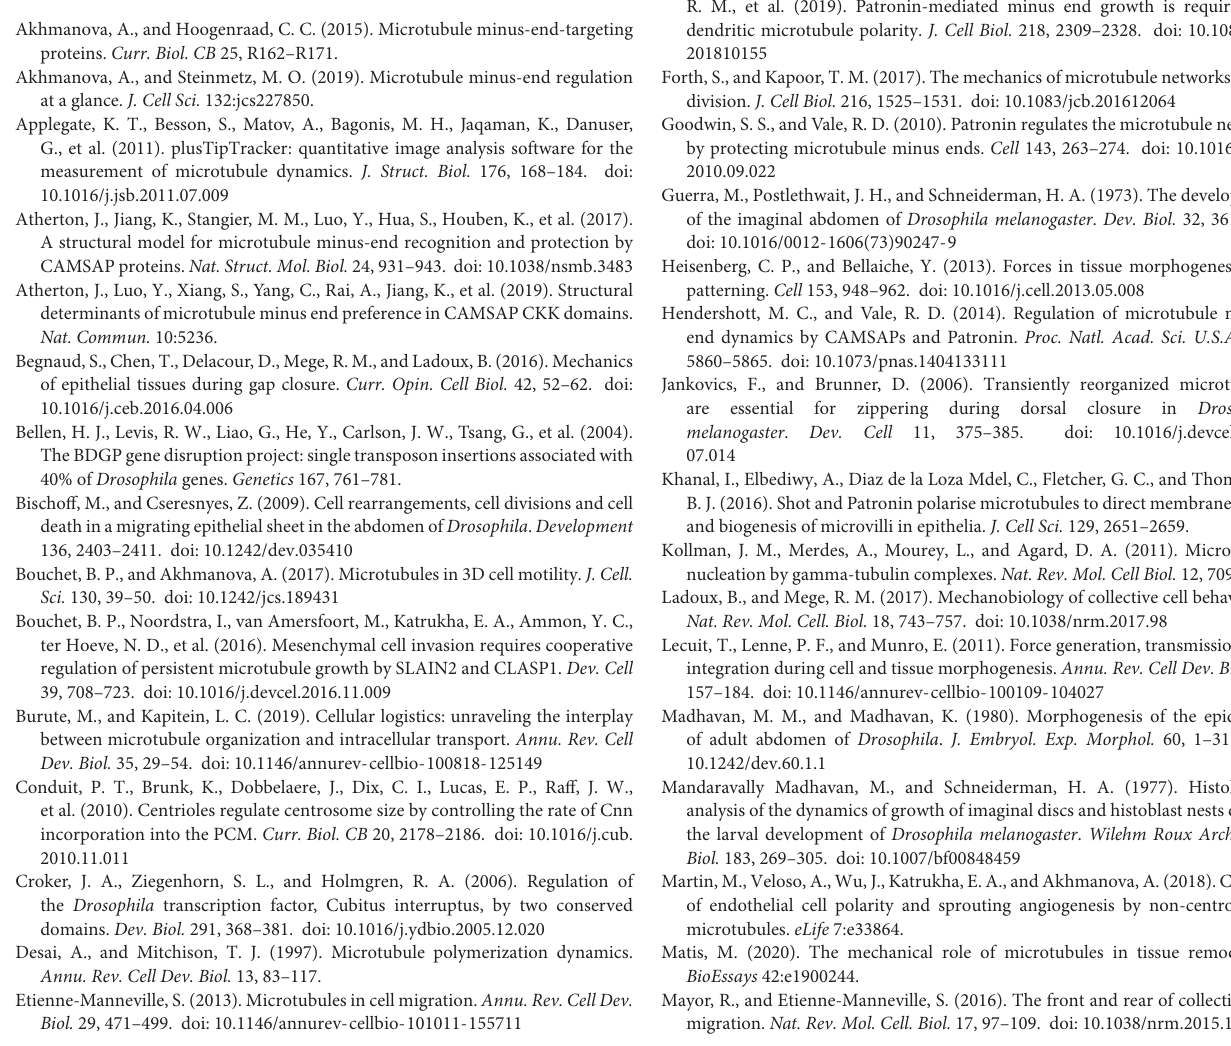
Supplementary Video 1 | Time-lapse video of migrating histoblast in segment A3 during dorsal abdomen formation (24–29 h APF) expressing Arm-GFP. Scale bar, 25 µ m. Supplementary Video 2 | Time-lapse video of EB1-GFP marking microtubule plus-ends (25–26 h APF) in wild-type histoblast, related to Figure 3A . Scale bar, 5 µ m. Figure 3B . Scale bar, 5 µ m. Supplementary Video 4 | Time-lapse video of migrating histoblast in segment A3. Histoblast nuclei are labeled with the Histone-mRFP and patronin ey 05252 mutant cells are labeled with GFP, related to Supplementary Figure 3 . Scale bar, 10 µ m. Supplementary Video 5 | Time-lapse video of migrating histoblast in segment A3. The tracks represent paths of the cells expressing nuclear marker Histone-mRFP moving in the direction of migration axis, related to Figure 5 . Scale bar = 20 µ